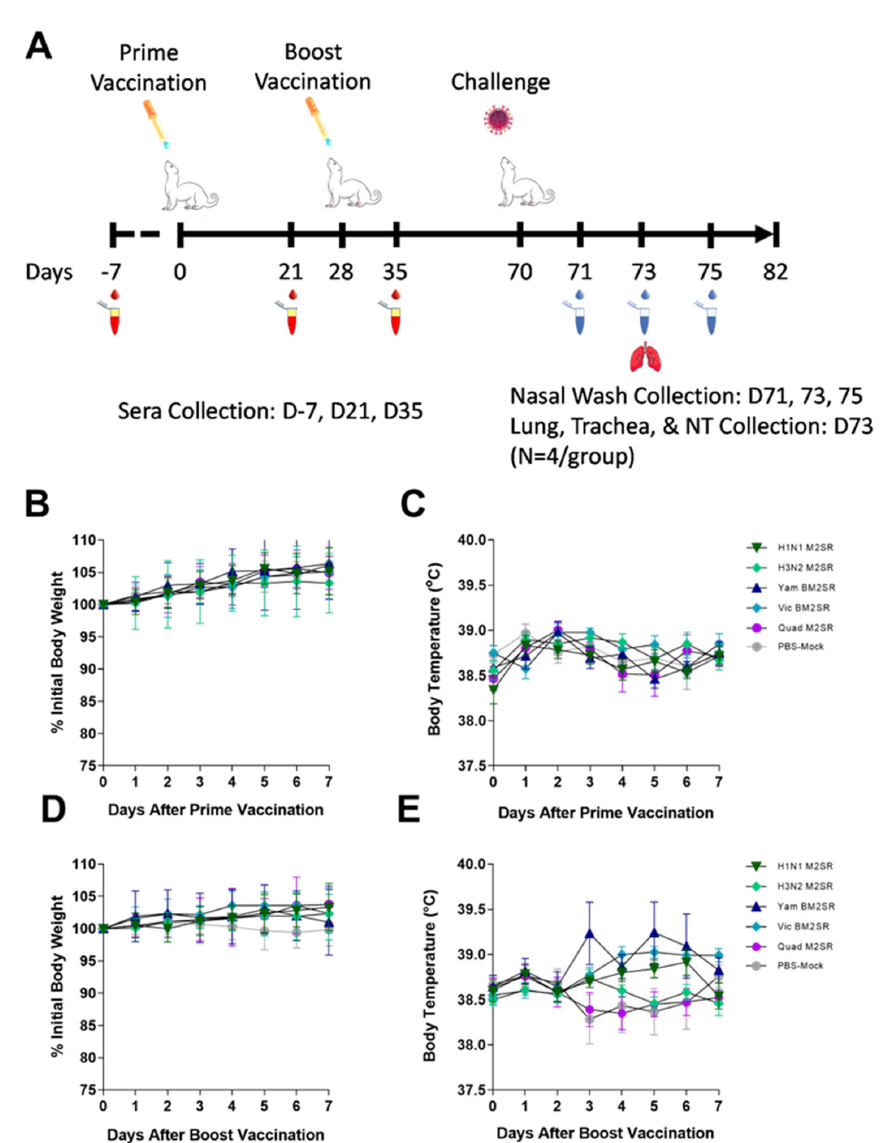
Figure 5. Vaccination scheme, sampling regimen, body weight, and temperature changes in ferrets following M2SR vaccination. ( A ) Groups of ferrets were intranasally vaccinated with H1N1 M2SR (A/California/07/2009), H3N2 M2SR (A/Brisbane/10/2007), Yam BM2SR (B/Wisconsin/01/2010), Vic BM2SR (B/Brisbane/60/2008), or each of the four monovalent strains formulated together (Quad M2SR) on Day 0 and again on Day 28. Serum samples were collected pre-study and on days 21 and 35. Ferrets were challenged with a 10 6 PFU dose of A/California/07/2009 (H1N1 pdm) on Day 70. Nasal washes were taken on days 71, 73, and 75, and lung trachea and nasal turbinates were collected from 4 ferrets/group on Day 73. Body weight and temperature were monitored for 7 days following prime inoculation (( B , C ), respectively) and again 28 days later following boost inoculation (( D , E ),